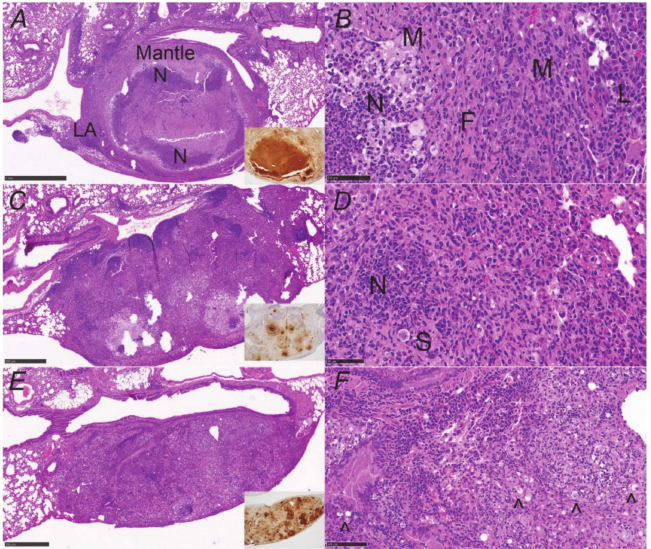
Figure 5. Granuloma destruction over time with DXM suppression. ( A ) Structure of a controlled granuloma showing it is well-demarcated from the surrounding lung and consists of a necrotic center with many neutrophils (N) and a mantle region composed of macrophages, fibroblasts, scattered neutrophils, and scattered lymphocytes (inset, neutrophil stain). Lymphoid aggregates (LA) are common on the periphery of the margin. ( B ) Higher-power image of ( A ) highlighting layers; F = fibroblasts, M = macrophages, L = lymphocytes, and N = neutrophils. ( C ) Day 5 of DXM administration shows a huge reduction in neutrophils in the core of the lesion (inset, neutrophil stain) and ( D ) is a higher-power image from the right side of the periphery with a large spherule (S) and a cluster of neutrophils (N) near the margins of the lesion. ( E ) Day 20 lesion showing complete loss of granuloma structure characterized by mixed inflammation of macrophages and resurgent neutrophils (inset, neutrophil stain) (pyogranulomatous lesion) with innumerable spherules throughout. ( F ) High-power image of ( E ) with some of the abundant spherules marked (black carat). Sheets of plasma cells are the main lymphocytic cells present. (H&E stain; insets—NIMP-R14 neutrophil stain. Magnification: ( A , C , E )— × 40; ( B , D , F )— ×